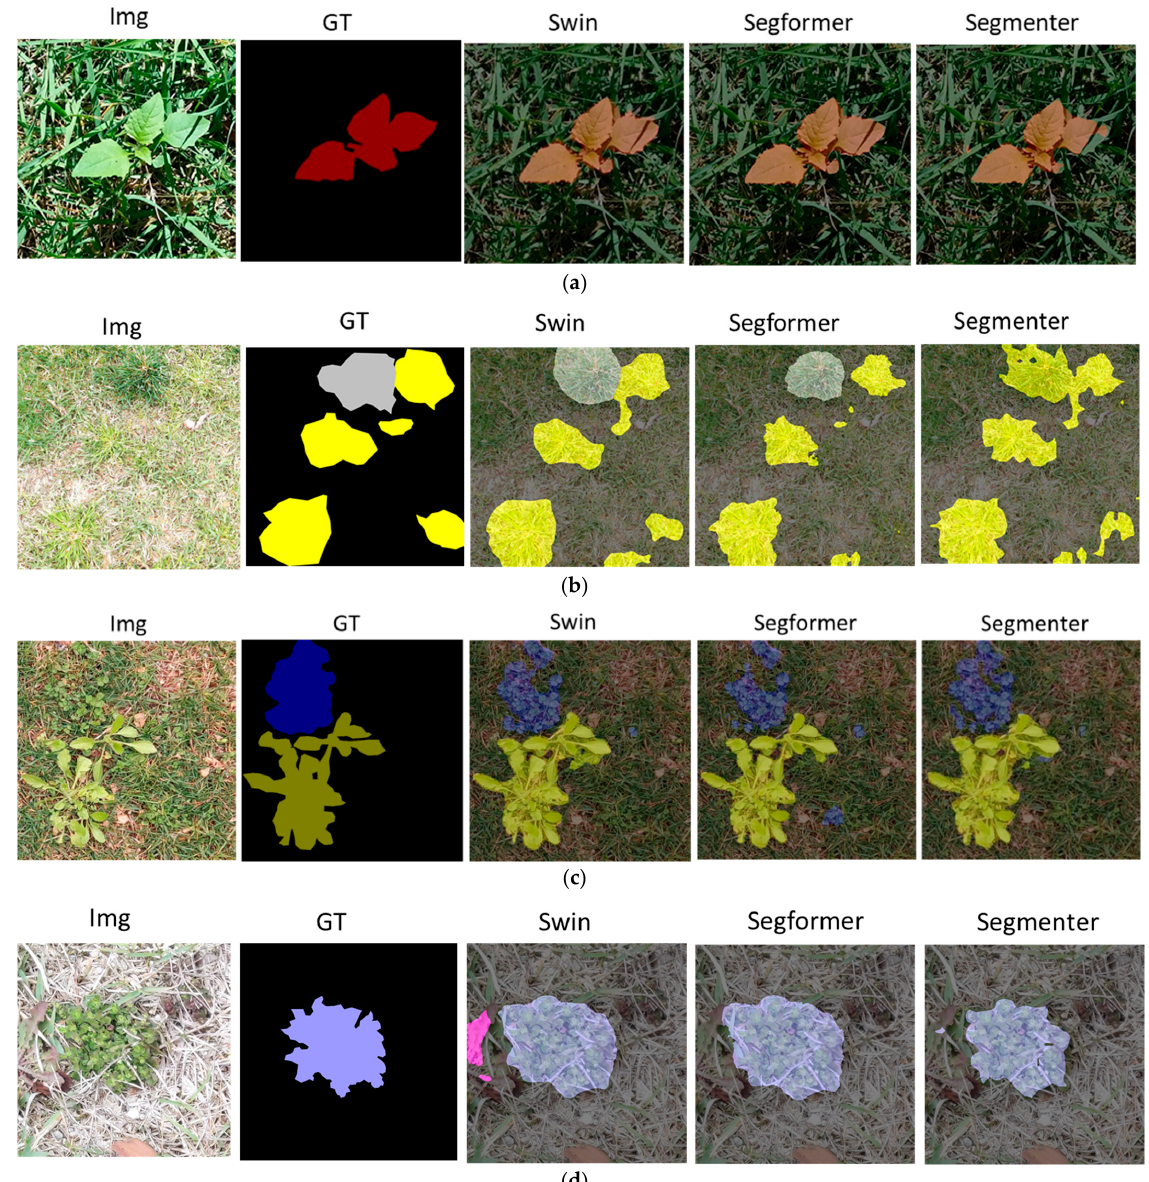
Figure 9. Partial model result visualization: ( a ) results of lambsquarter; ( b ) results of crabgrass and tall fescue; ( c ) results of clover and plantain; ( d ) results of ground ivy and dandelion.